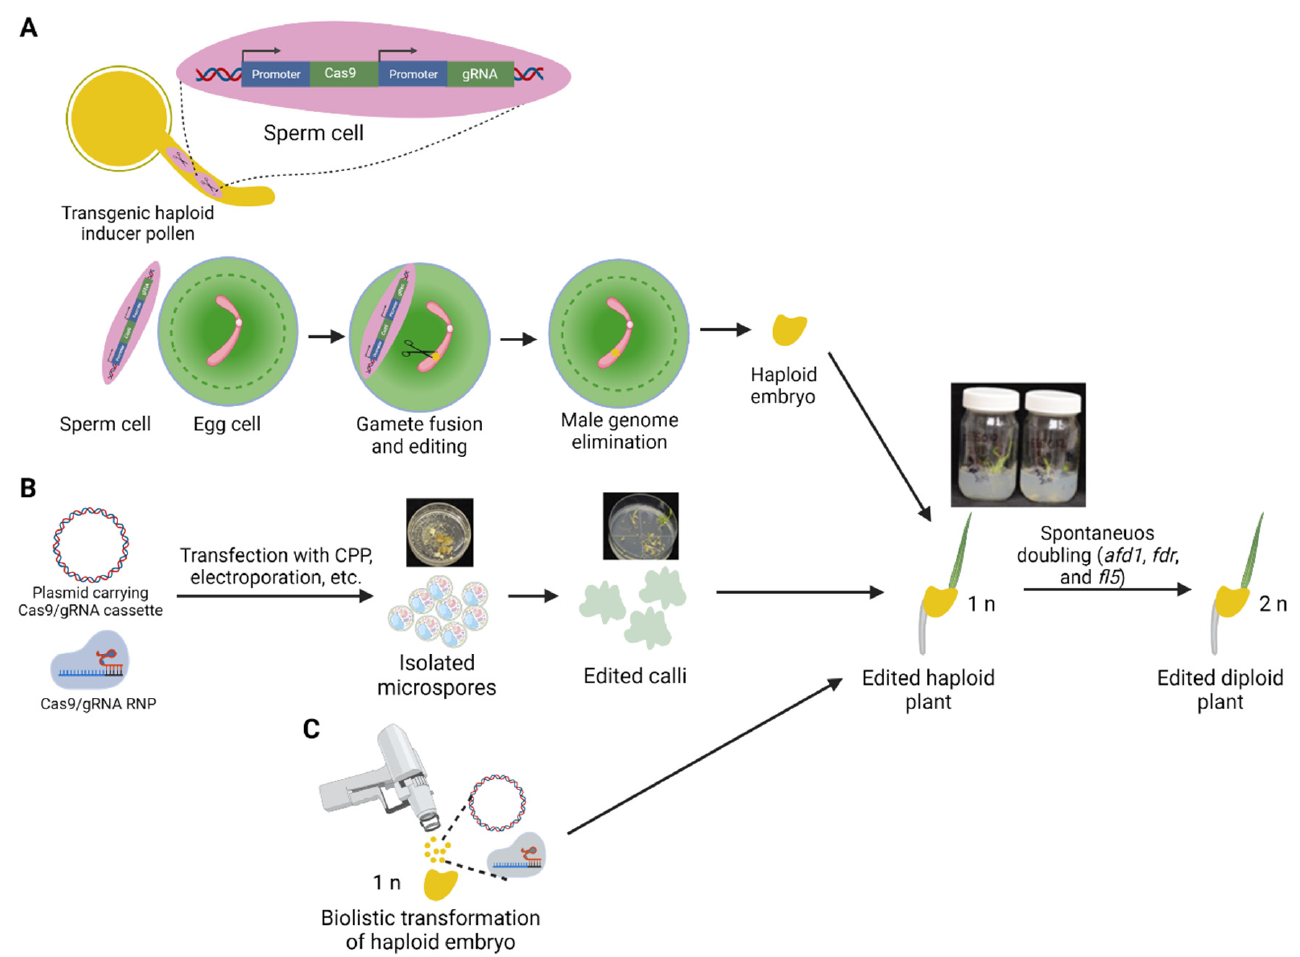
Figure 2. Gene editing in haploid tissues. ( A ) Editing of the maternal genome in maize or wheat using the Haploid Inducer-Mediated Genome Editing (IMGE) [95] or HI-Edit [96] methods through transient expression of the Cas9/gRNA cassette during pollination of non-inducer maize line with pollen from the HI line carrying the transgene. ( B ) Gene editing through transfection of isolated microspores using either the Cas9/gRNA DNA cassette or ribonucleoprotein (RNP) complex followed by regeneration of the edited haploid plants. ( C ) Direct gene editing in haploid tissues through biolistic delivery of the transgene or Cas9/gRNA RNP. Following the regeneration of haploid plants ( n ), genome doubling (2 n ) can be attained by manipulating selected genes through artificial or spontaneous doubling. afd1 — absence of first division1 , fdr — first division restitution , fl5—formin-like-5 . Created with